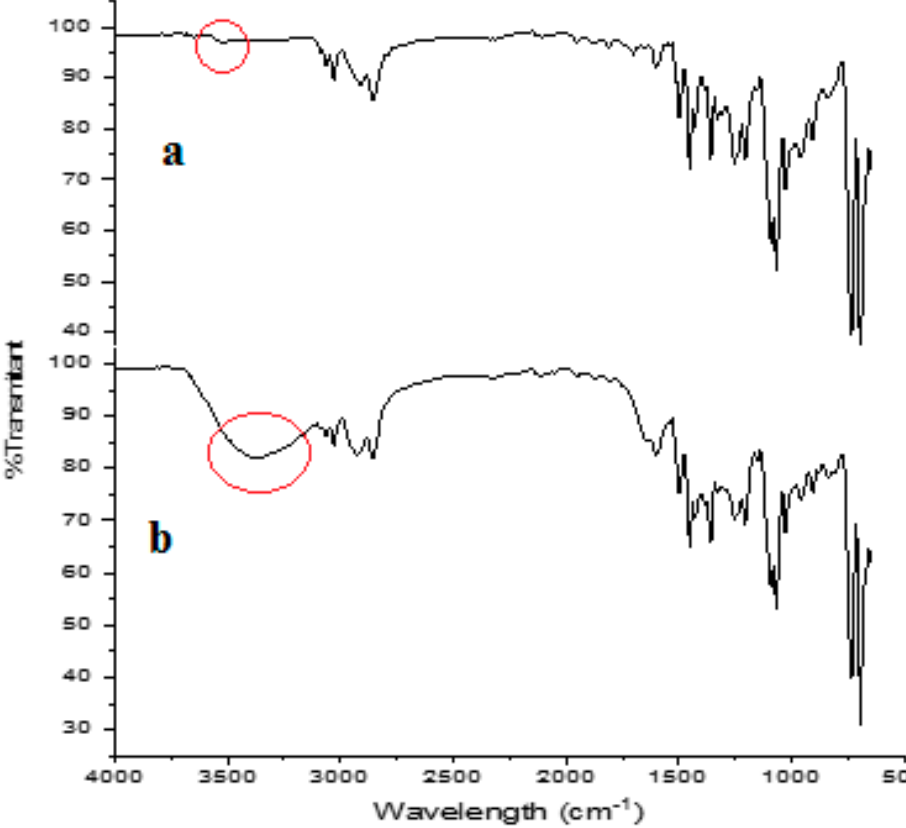
Figure 9. FT-IR spectra of PIM membrane ( a ) before transport and ( b ) after transport. Red cycle represents the hydroxyl peak on the PIM before and after transport.